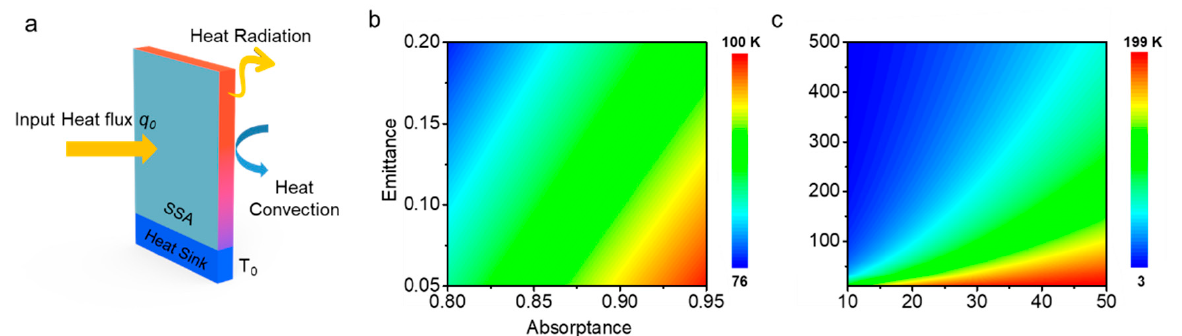
Figure 3. Effect of spectral and geometric parameters on the film thermal performance. ( a ) Schematic model of the three-dimensional heat transfer process. The theoretical maximum temperature differences under the influence of ( b ) solar absorptance and thermal emittance of the SSA coating, ( c ) thickness and length of the film.